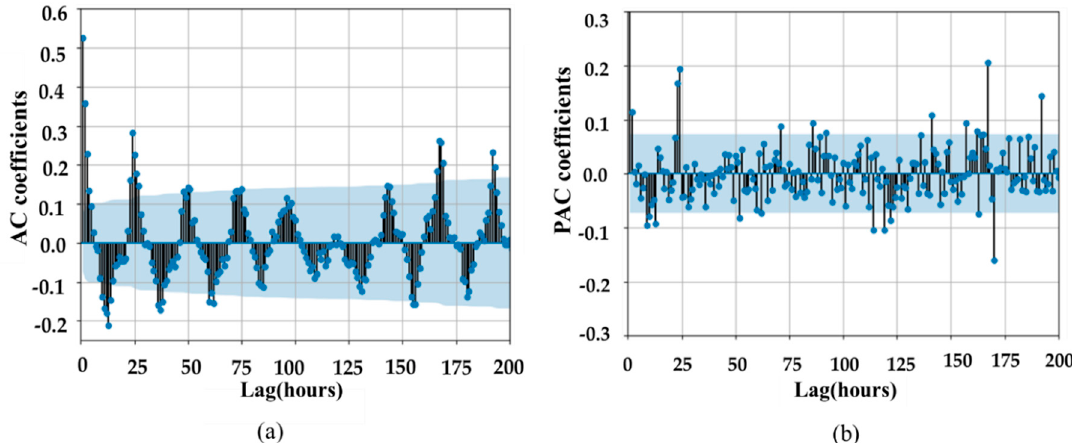
Figure 4. Auto-correlation of residual load series with different time lagging: ( a ) auto-correlation (AC) coefficients, and ( b ) partial auto-correlation (PAC) coefficients.